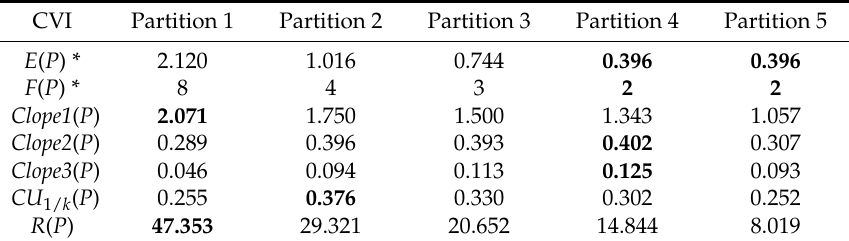
Table 3. Evaluation results of the partitions in Table